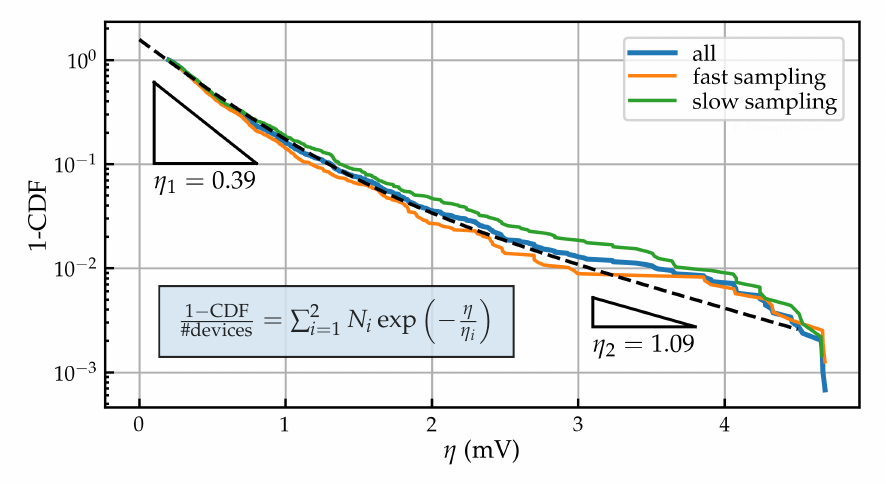
Figure 5. Complementary cumulative density function (1-CDF) of the step heights η extracted from our measurements, shown for both the slow and the fast sampled data. The distribution seems to be bimodal, composed of a defect distribution with a smaller average impact η 1 and a distribution with a larger impact η 2 .